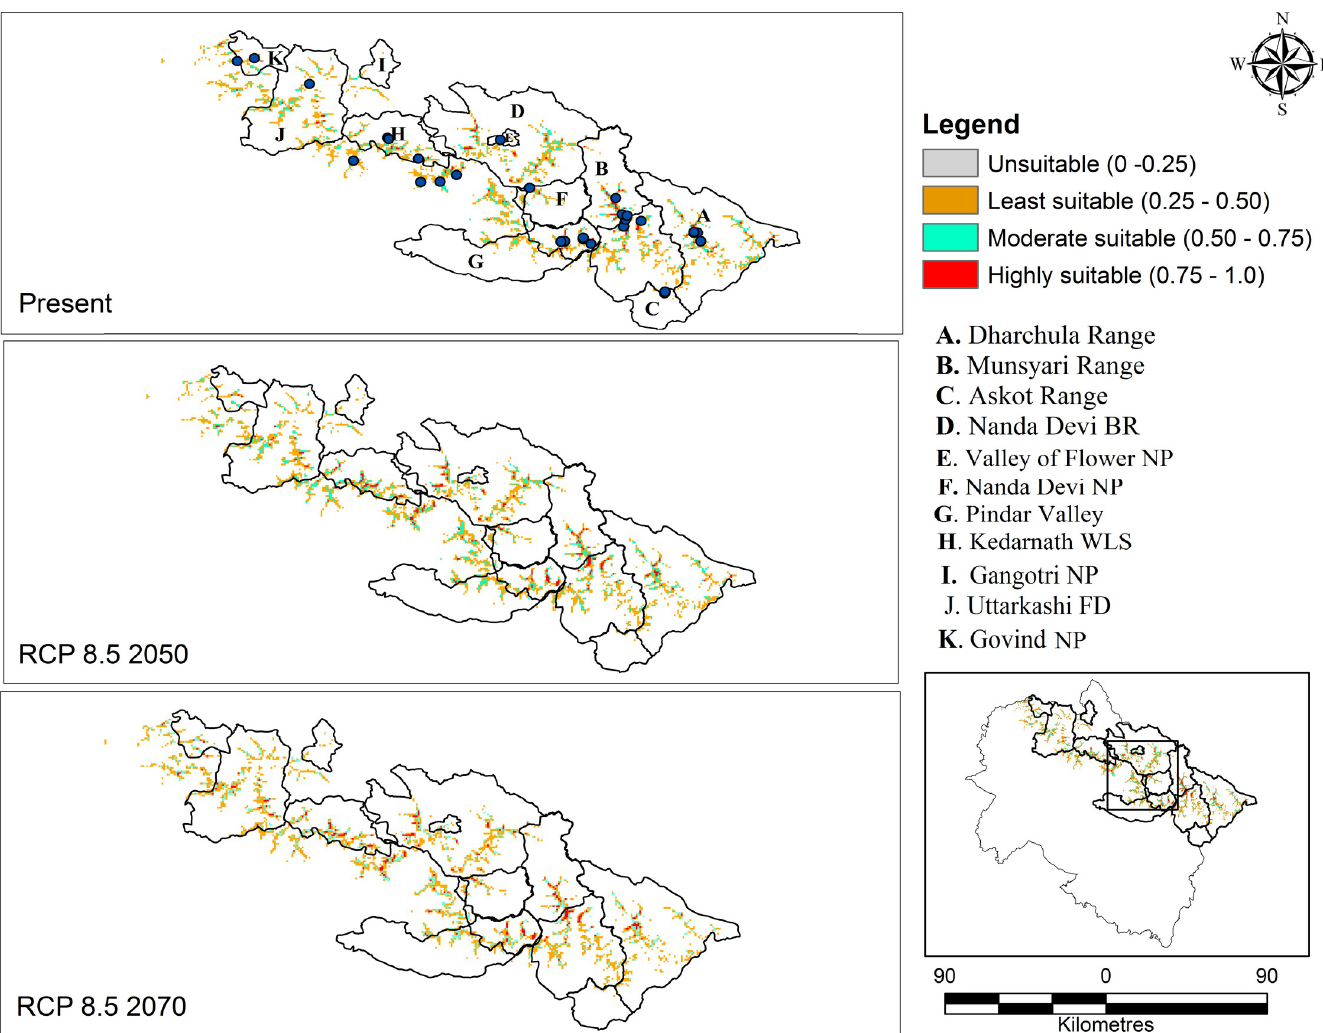
Fig 7. n-depth view of predicted future habitat for D . hatagirea under RCP 8.5 (2050 & 2070). I Maps in Fig 6 are generated with ArcGIS version 10.3 (ESRI, CA, USA).